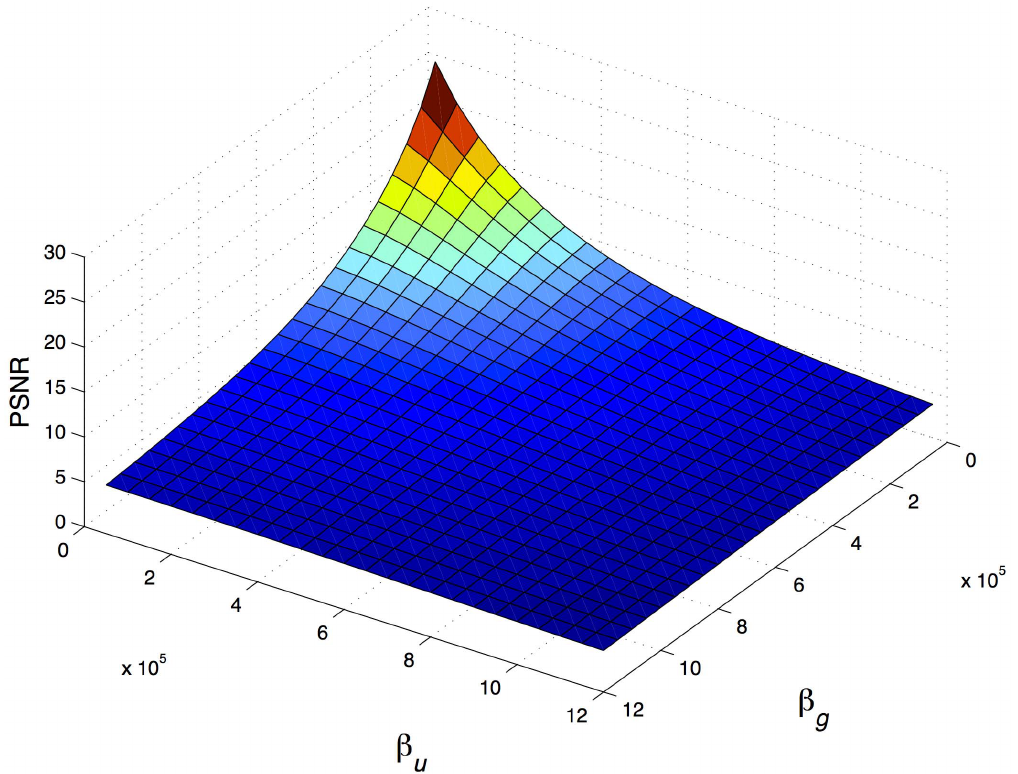
Figure 1. Distortion generated in digital documents due to fingerprint insertion varying the energy assigned to users ( b u ) and groups( b g ), with fixed values of fingerprint length ( L ) and insertion position ( P w ). Low PSNR values implies high distortion. doi:10.1371/journal.pone.0081976.g001 PLOS ONE |